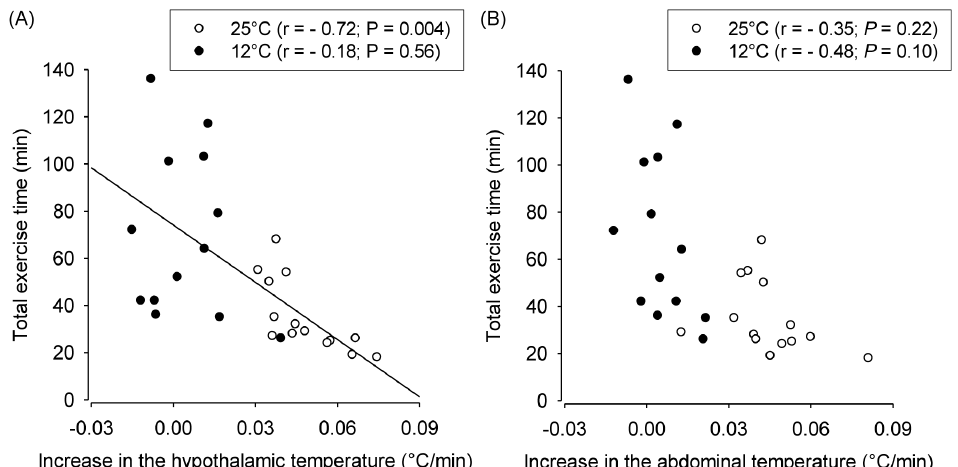
Figure 6. Correlation between the rate of increase in the hypothalamic temperature (panel A) or the abdominal temperature (panel B) and the total exercise time during constant-speed running at ambient temperatures of 25 u C and 12 u